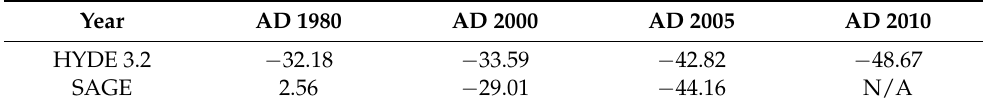
Table 3. The relative difference rates between HYDE 3.2, SAGE, and the remote sensing source CWLUCC from the 1980s to 2010 in Xinjiang area (unit: